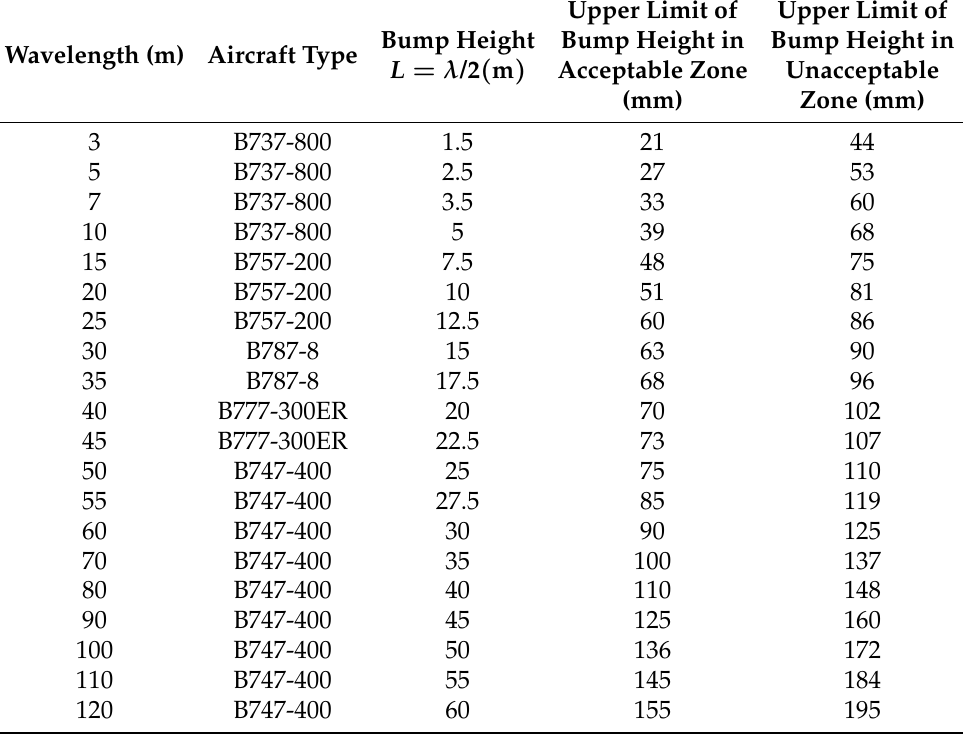
Table 10. Limits of Boeing Bump height in acceptable zone and unacceptable zone.